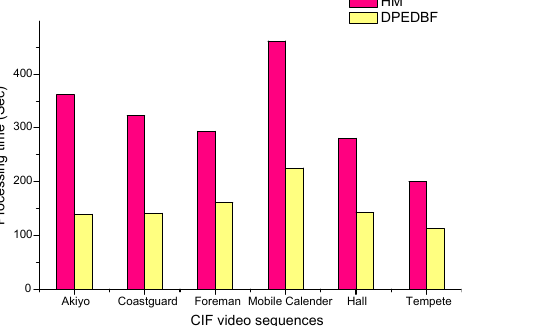
Figure 24. Comparison of processing time with HM for CIF video sequences using QP =